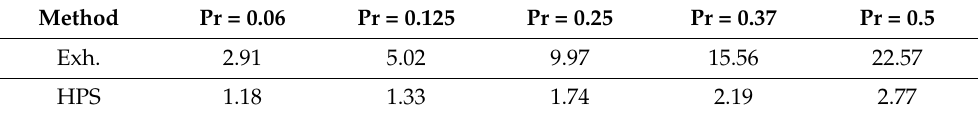
Figure 2. Accuracies for pruning an FC layer in Lenet5 HPS vs. pruning exhaustively. Table 3. Computation time in seconds for the pruning process in Lenet5 architecture.